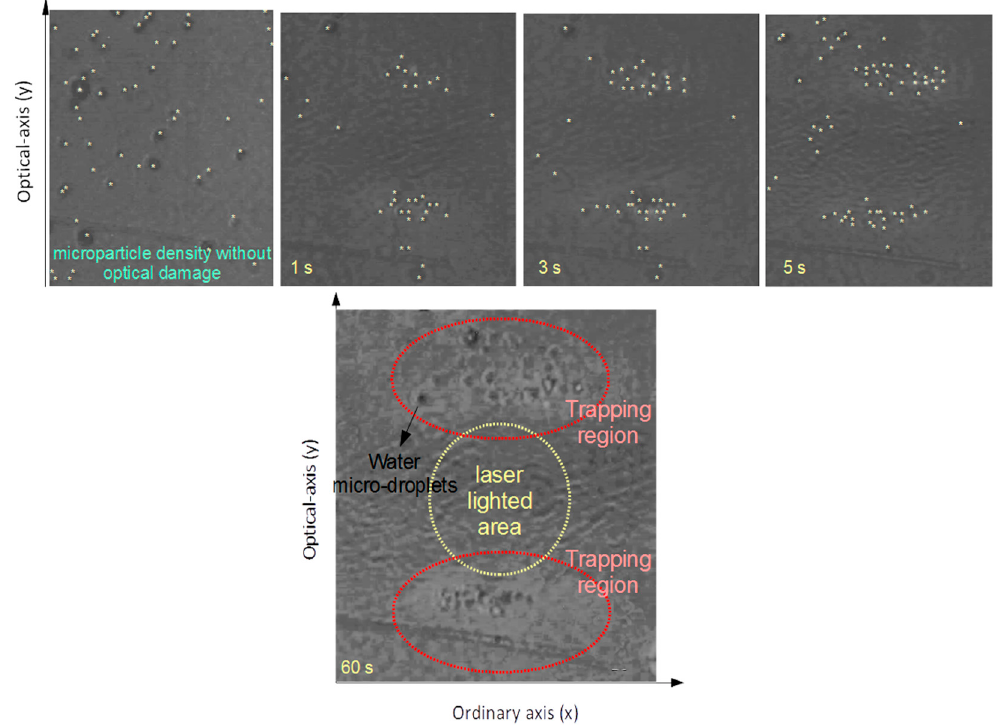
Figure 6. Top : sequence of frames showing the water-droplet movement in paraffin-oil towards the trapping area. The center of each droplet is marked with a small white star to highlight their positions and movement. It can be observed that an increasing number of droplets are attracted in the camera’s area. Bottom : overview of the optical damage with trapped water micro-droplets.